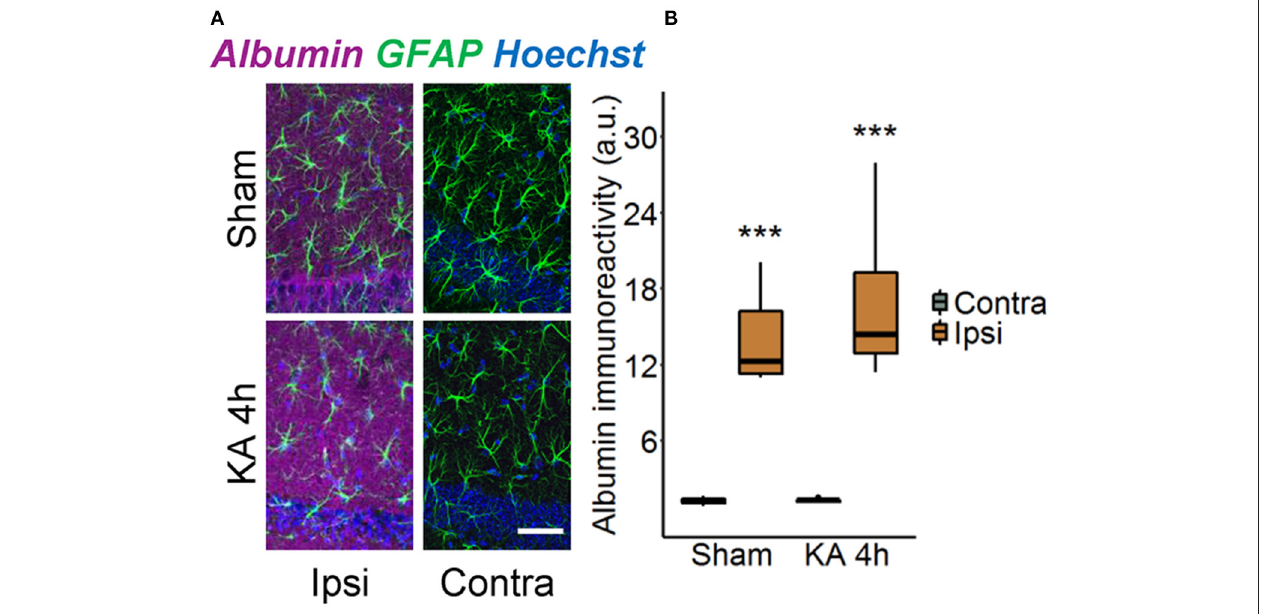
FIGURE 1 | Ipsilateral albumin extravasation 4h after status epilepticus (SE) induction. (A) Representative maximum intensity projections depicting albumin (magenta), GFAP (green), and Hoechst (blue) labeling in ipsi- and contralateral hippocampal slices of sham- and kainate-injected mice. Scale bar: 50 µ m. (B) Quantification of the staining revealed substantially higher ipsilateral vs. contralateral albumin extravasation after injection of both kainate and saline. Box plots represent median and quartiles. *** p < 0.001 vs. contralateral (two-way ANOVA). N = 9 slices from three mice/group. KA, kainate; au, arbitrary